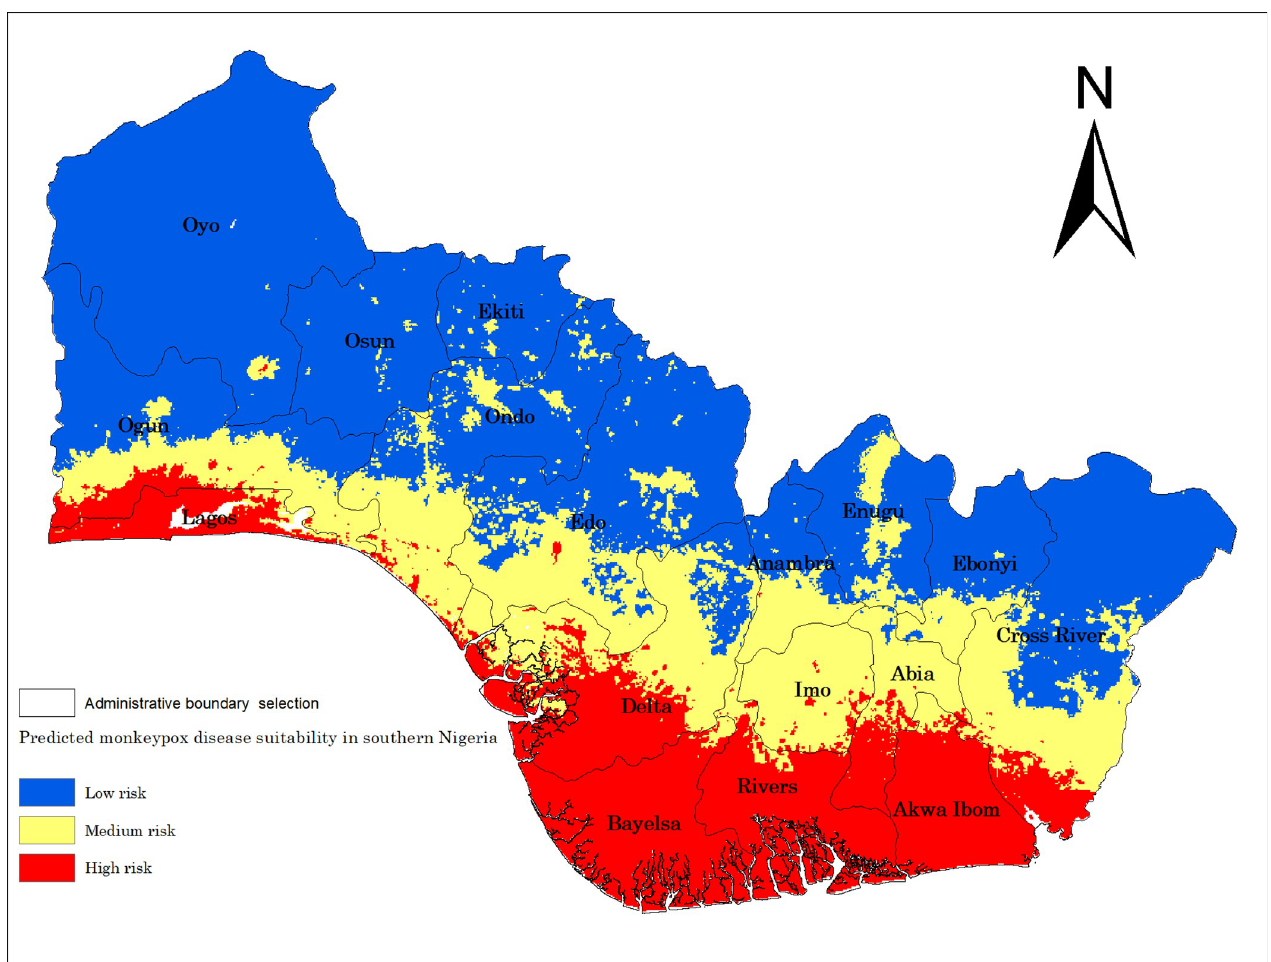
Fig 5. Ecological suitability map of monkeypox disease in southern